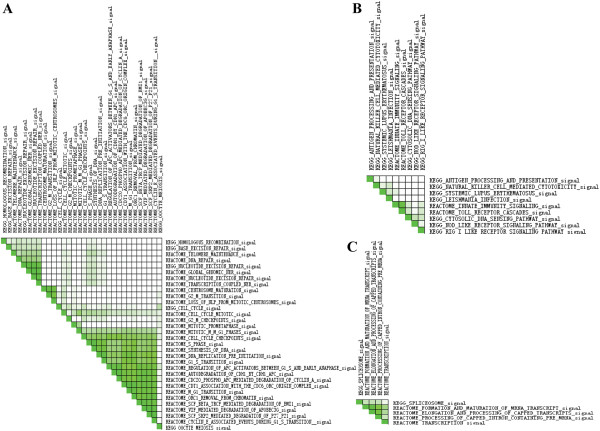
Leading edge analyses for the gene sets related to cell cycle, immune response and transcriptional regulation identified between HIV and HCV mono-infected groups. Gene sets related to cell cycle (A), immune response (B) and gene expression (C) identified between HIV- and HCV-infected groups were analyzed by the leading edge analyses of GSEA software. The Set-to-Set maps use color intensity to show the overlap between subsets: the darker the color, the greater the overlap between the subsets.